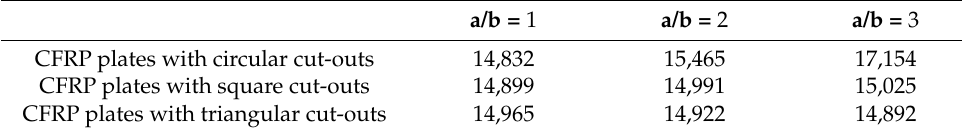
Table 3. Comparison of buckling loads in [N] for different cut-out shapes.